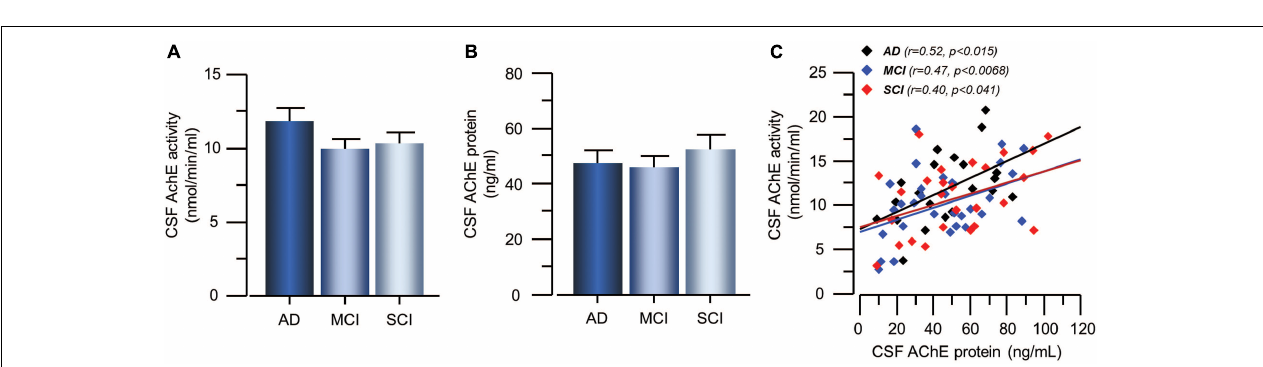
FIGURE 2 | Changes in ChAT levels in plasma of patients in different stages of dementia. (A) The plasma ChAT activity was higher in AD compared to patients with a clinical diagnosis of MCI or SCI. (B) A similar pattern of differences was found with regard to ChAT protein levels in plasma in the three groups. (C) Plasma ChAT activity correlated with its protein concentration in all three groups. AD = Alzheimer’s disease; ChAT = choline acetyltransferase; MCI = mild cognitive impairment; SCI = subjective cognitive impairment. * p < 0.05, *** p < 0.001, # p < 0.07.